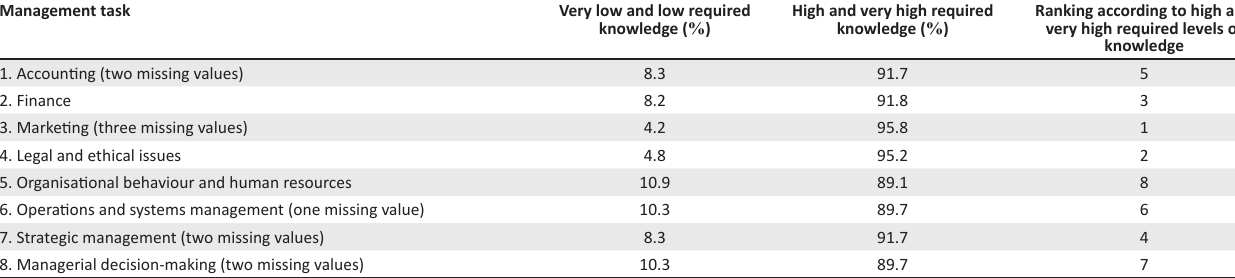
TABLE 3: Required levels of knowledge ( n = 147). Management